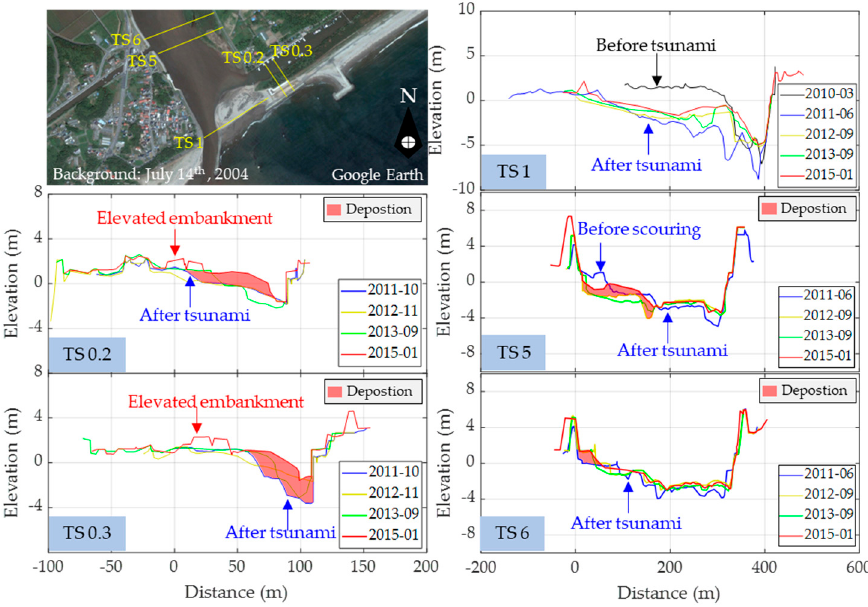
Figure 13. Deposited sediment in the Naruse River mouth after the tsunami (Datum: Tokyo Peil).